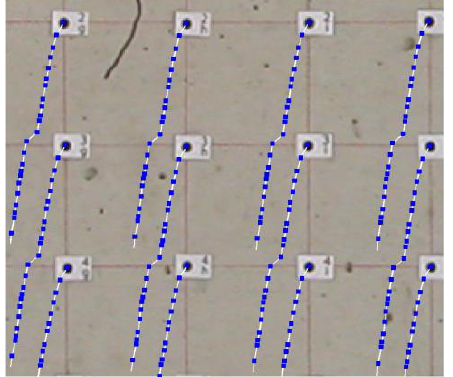
Figure 6. Target displacements projected onto the initial rectified